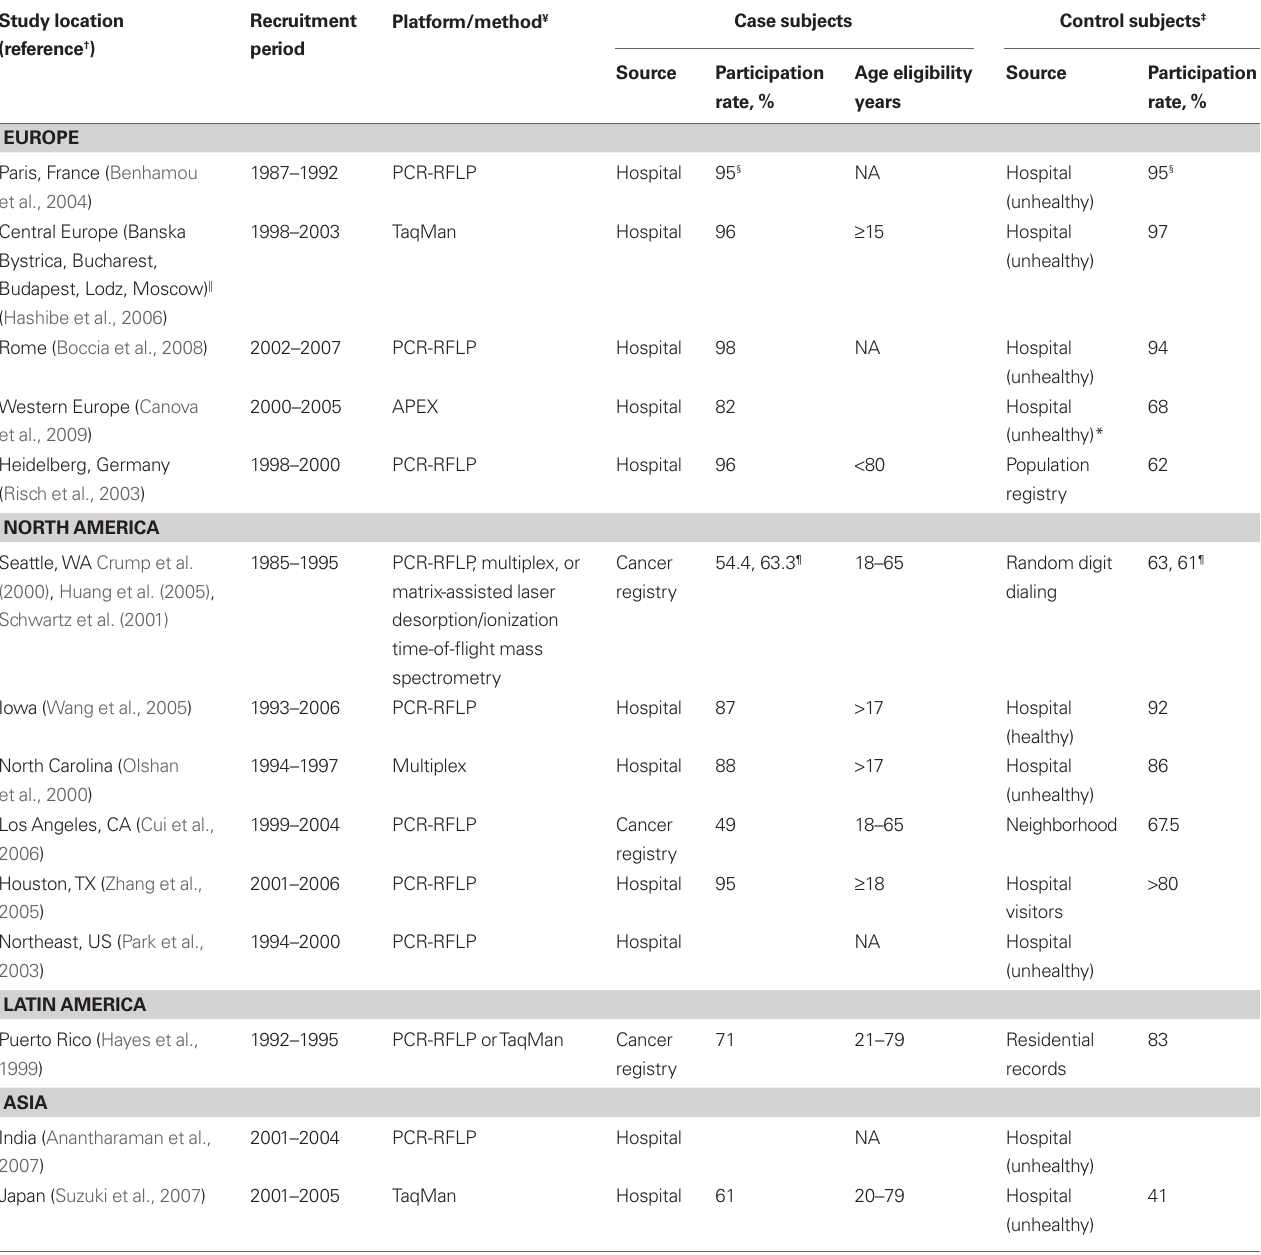
Table A1 | Summary of individual studies involved in the current